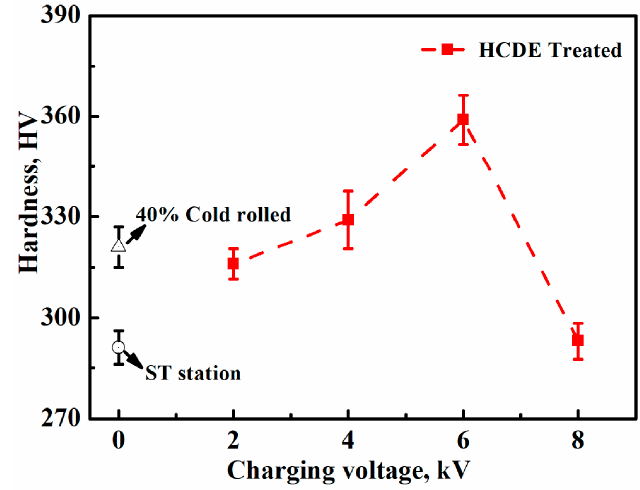
Figure 5. Variation of hardness with charging voltage and comparison with the ST specimen and 40% cold-rolled specimen. HCDE: high-current-density electropulsing. cold-rolled specimen. HCDE: high-current-density